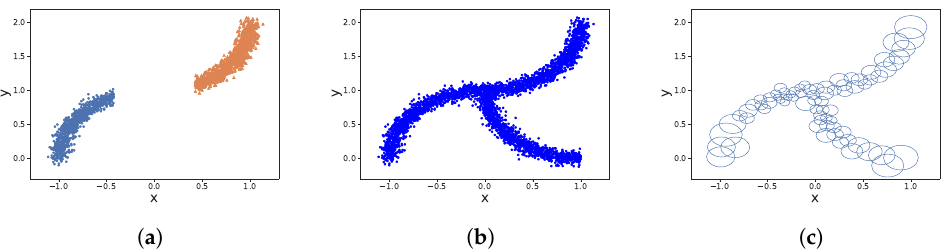
Figure 10. Validation of the Macro SOStream merge function with the T dataset. ( a ) Clustering of the first 1800 samples forming two distinct macroclusters, represented by different colors. ( b ) Final result. ( c ) Representation of the microclusters.